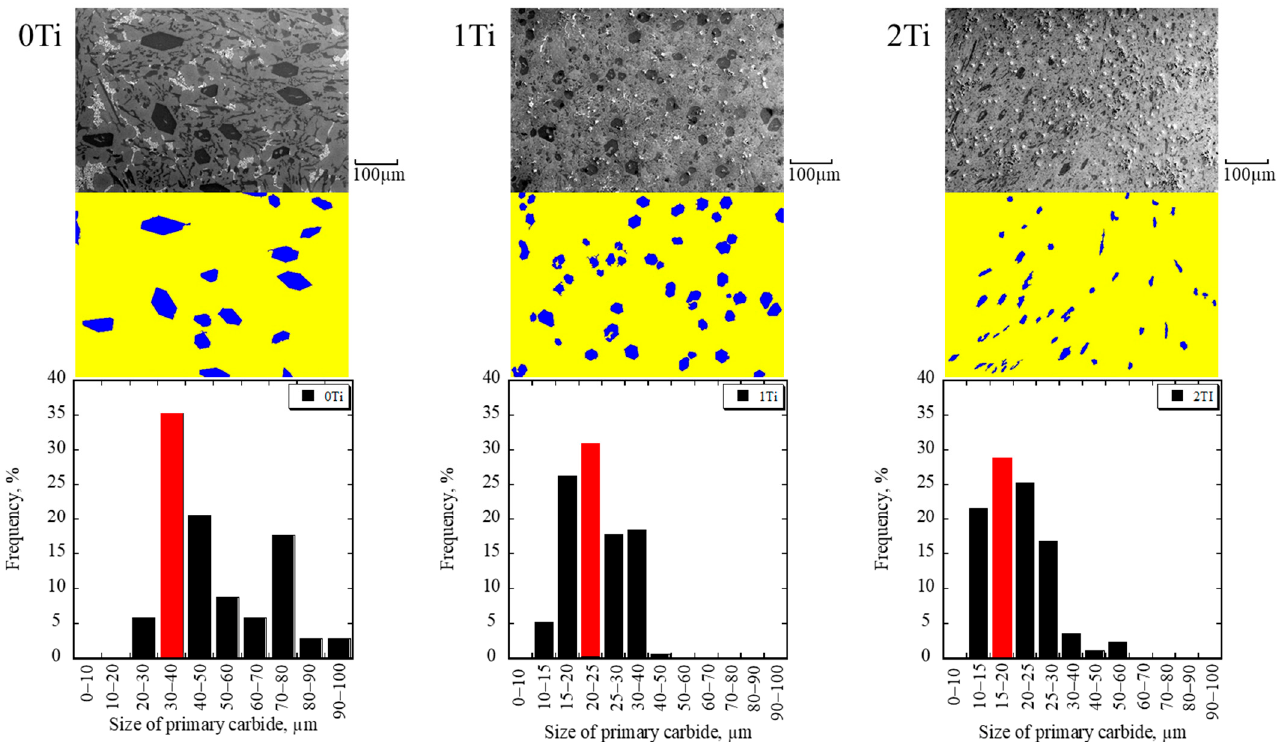
Figure 8. The distribution of primary M 7 C 3 carbide sizes of 0Ti, 1Ti, and 2Ti specimens.